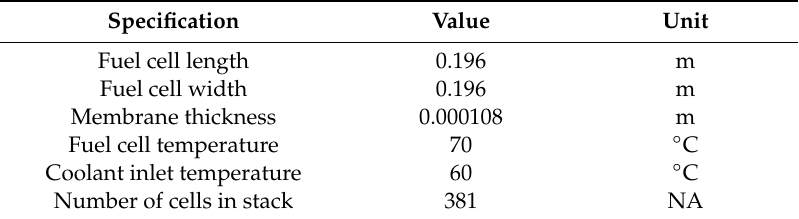
Table 1. Specifications of fuel cell